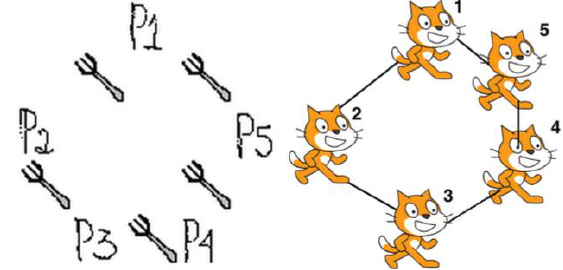
Fig. 6. Simulation environment for AgentSheets on the left, and Scratch, on the right.